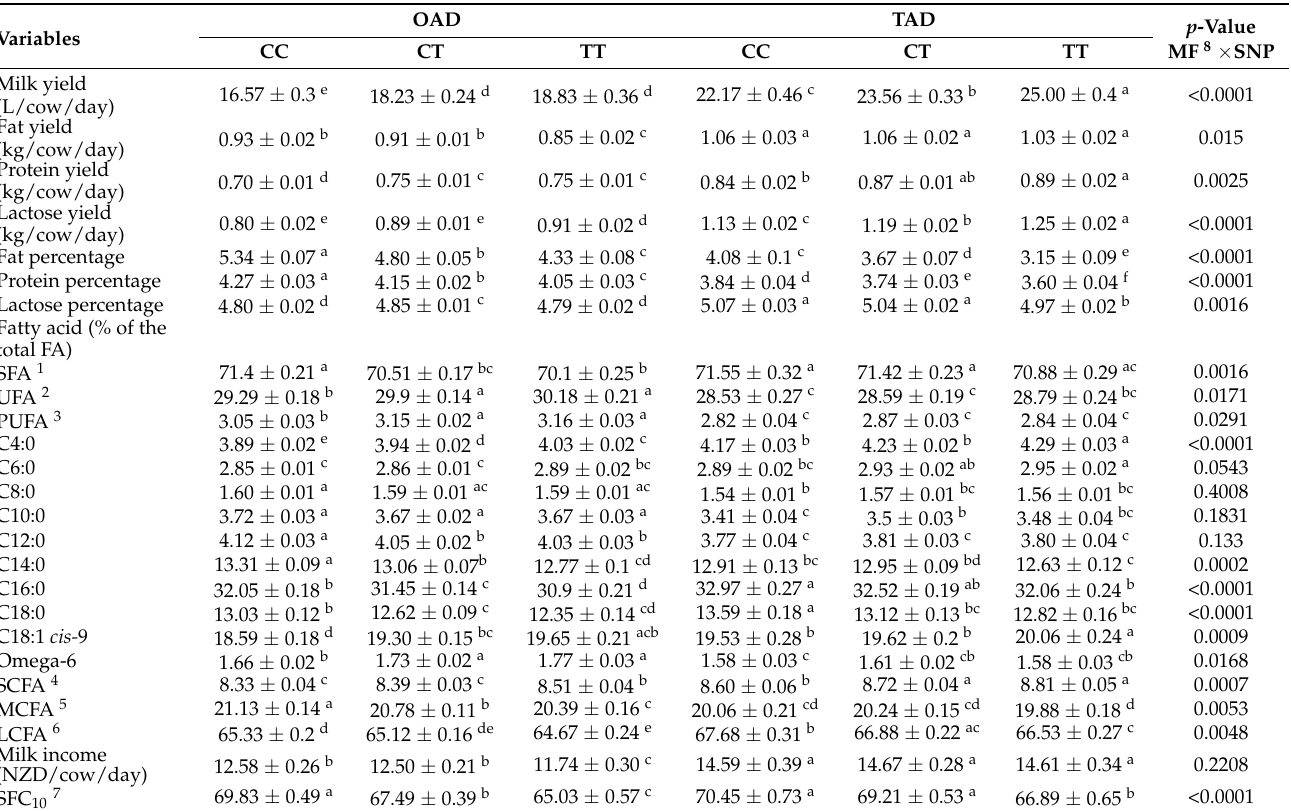
Table 4. Least-squares means and standard errors for the association between milk production traits, milk composition, and fatty acid composition and SNP rs109421300 genotypes for cows milked once a day (OAD) and twice a day